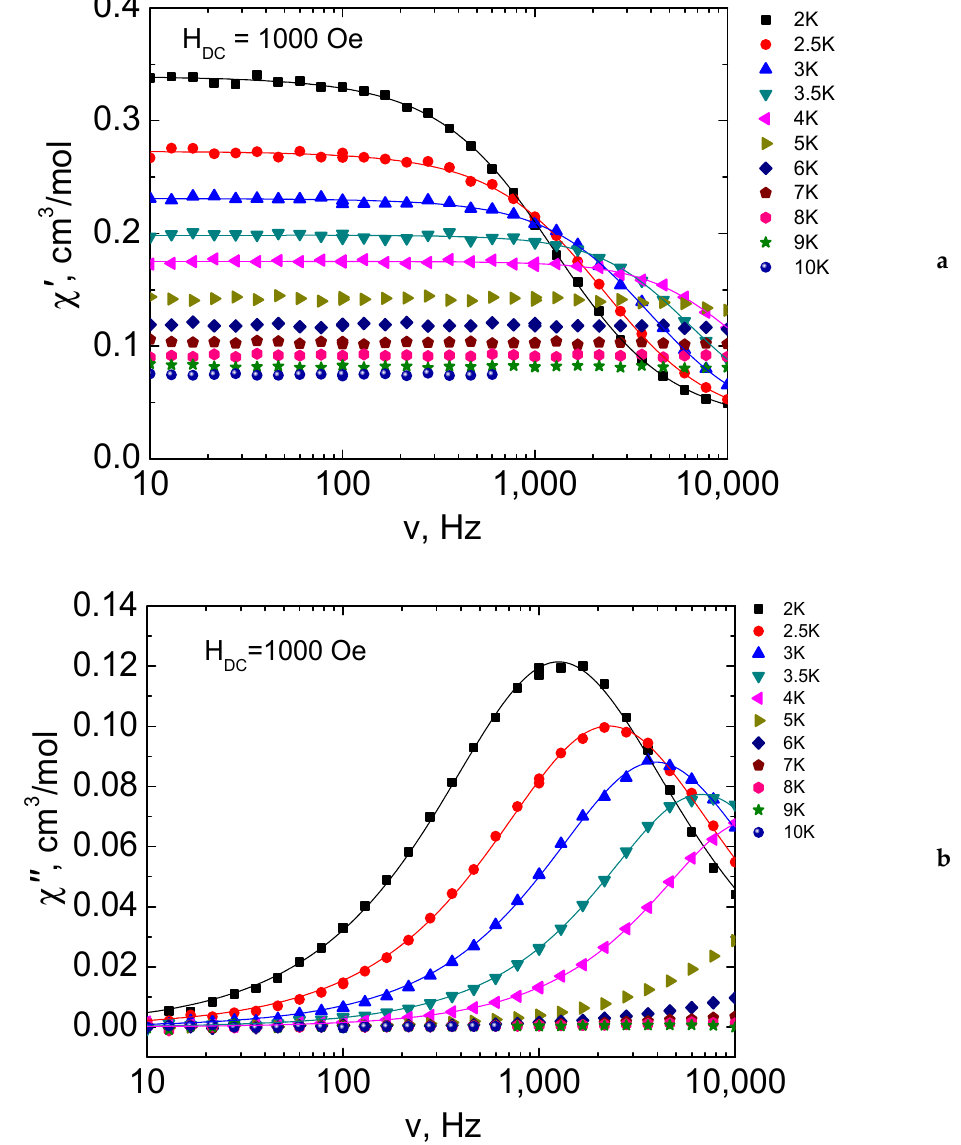
Figure 9. Frequency dependences of the real ( χ′ , ( a )) and imaginary ( χ″ , ( b )) components of the ac-magnetic susceptibility for complex 7 in the 1000 Oe dc-field. The lines are the best-fits by the generalized Debye model.